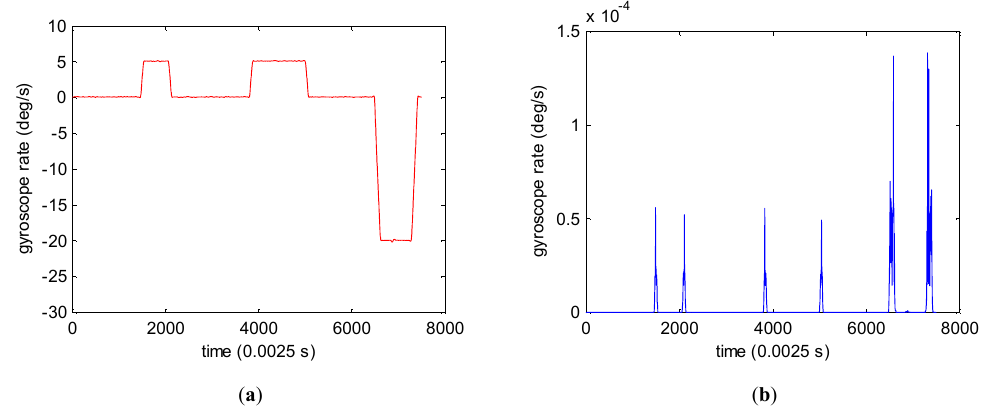
Figure 2. Sample variance. ( a ) Gyroscope signal. ( b ) Sample variance.